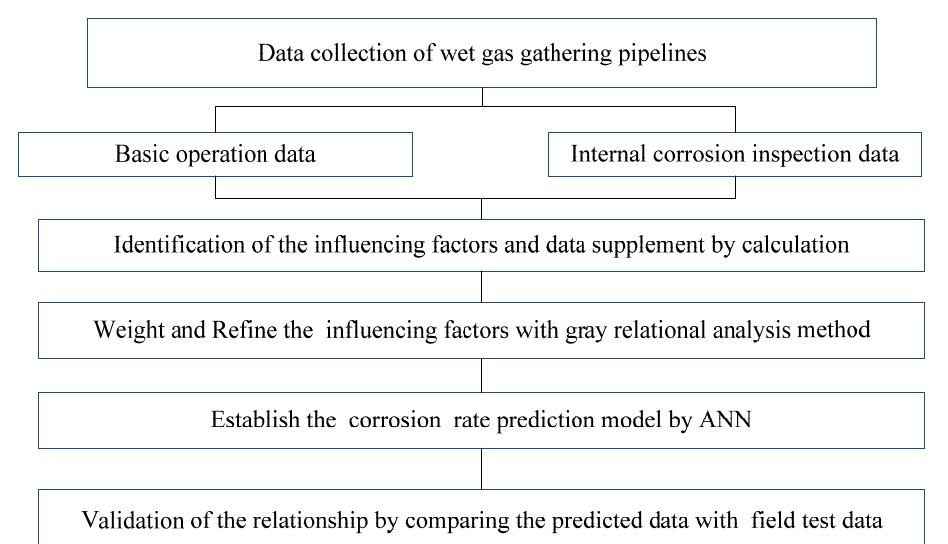
Figure 1. The logic diagram used to establish the